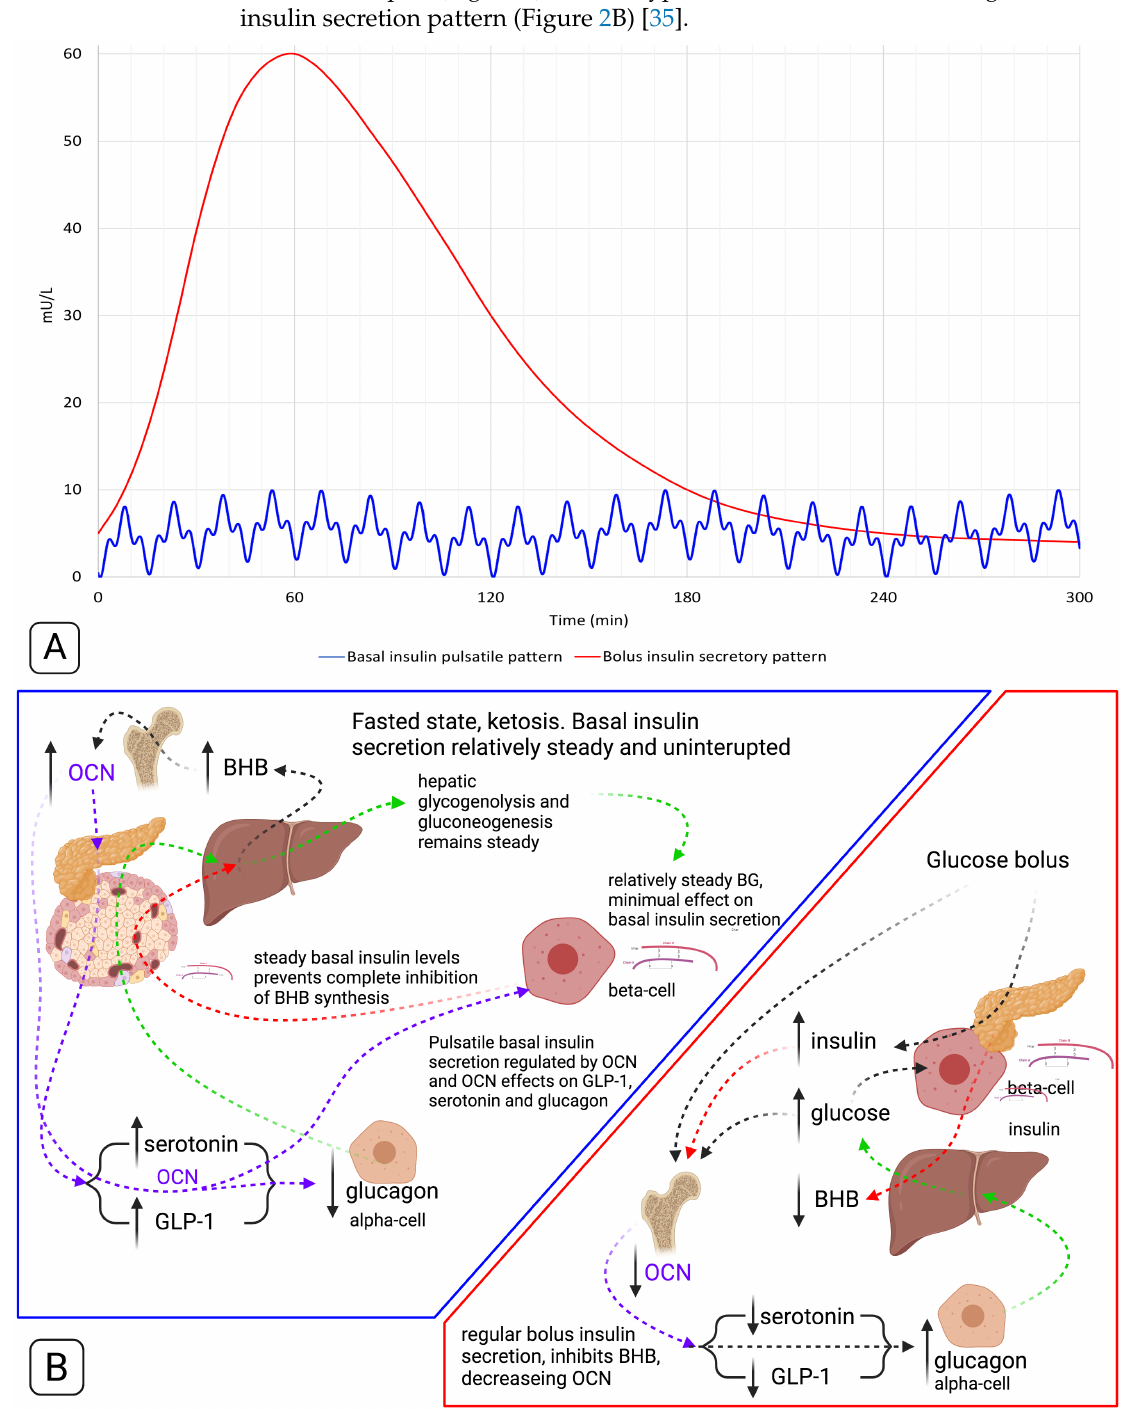
Figure 2. Schematic representations of basal and bolus insulin secretory patterns ( A ) and secretion regulation ( B ). ( A ) The red line conceptually models glucose bolus mediated insulin secretory response pattern (Kraft I) [36], and the blue line conceptually models basal insulin pulsatile secretory pattern, in metabolically healthy individuals [34]. ( B ) Schematic representation of the regulatory cycles of basal and bolus insulin secretion in metabolically healthy, habitually fasted individuals. Beta-hydroxybutyrate (BHB), blood glucose (BG), glucagon-like peptide-1 (GLP-1), osteocalcin